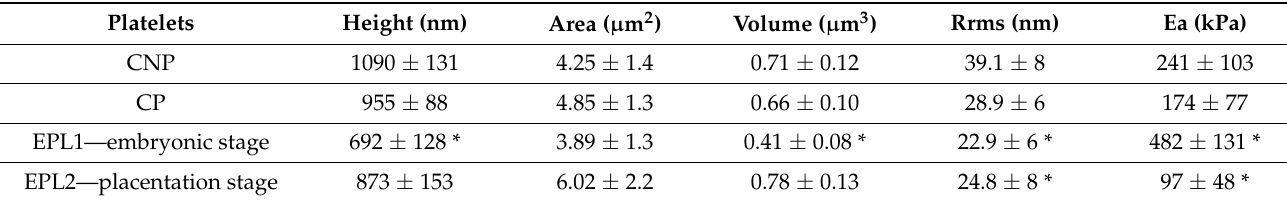
Table 3. Morphological (height, spreading area and roughness) and nanomechanical (Young’s modulus, Ea) characteristics of platelets obtained from non-pregnant women (CNP), women with normal pregnancy (CP) and women with early pregnancy loss (EPL), presented as mean value and standard deviation.